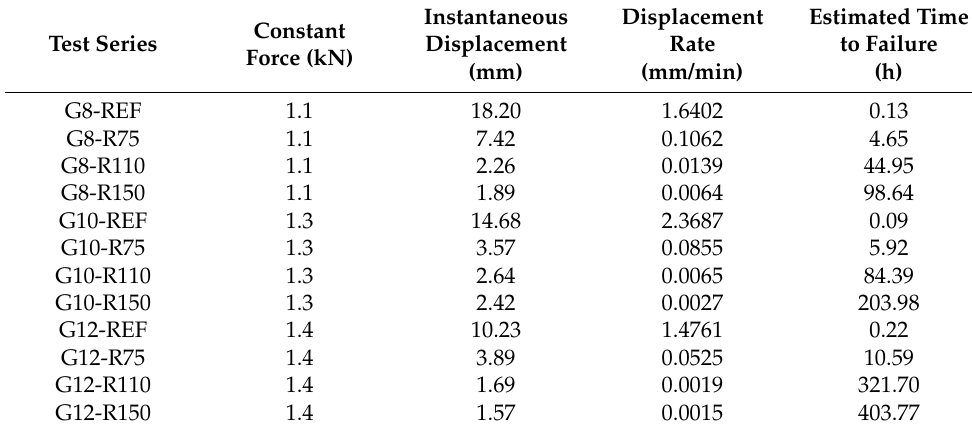
Table 3. Results of creep